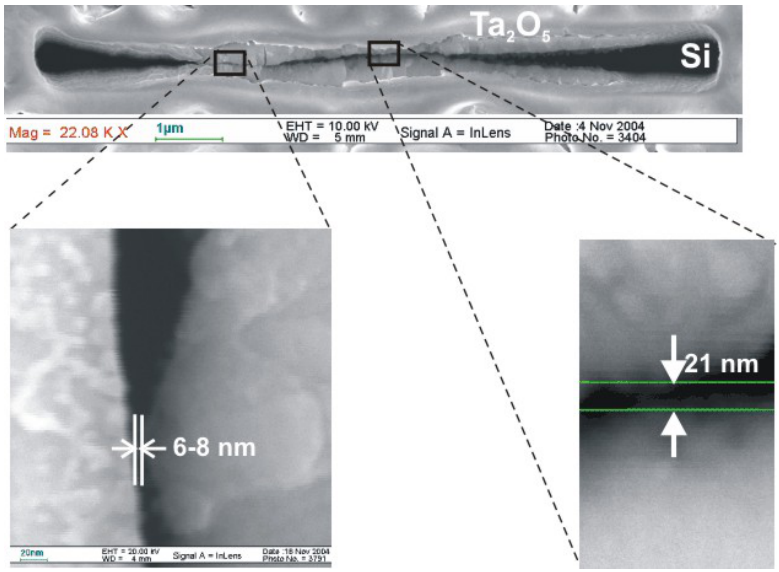
Figure 5. Experimental demonstration of feasibility of the proposed method for the preparation of even structures below 10